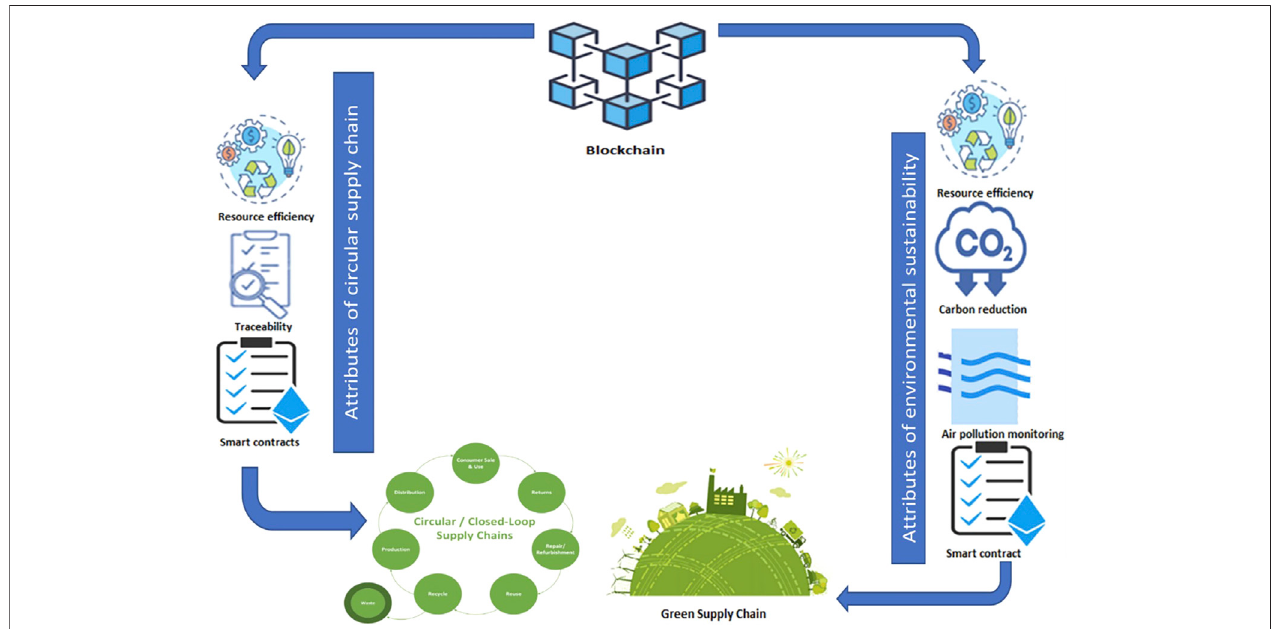
FIGURE 4 | Conceptual framework of transformation of the supply chain to the green/circular supply chain.